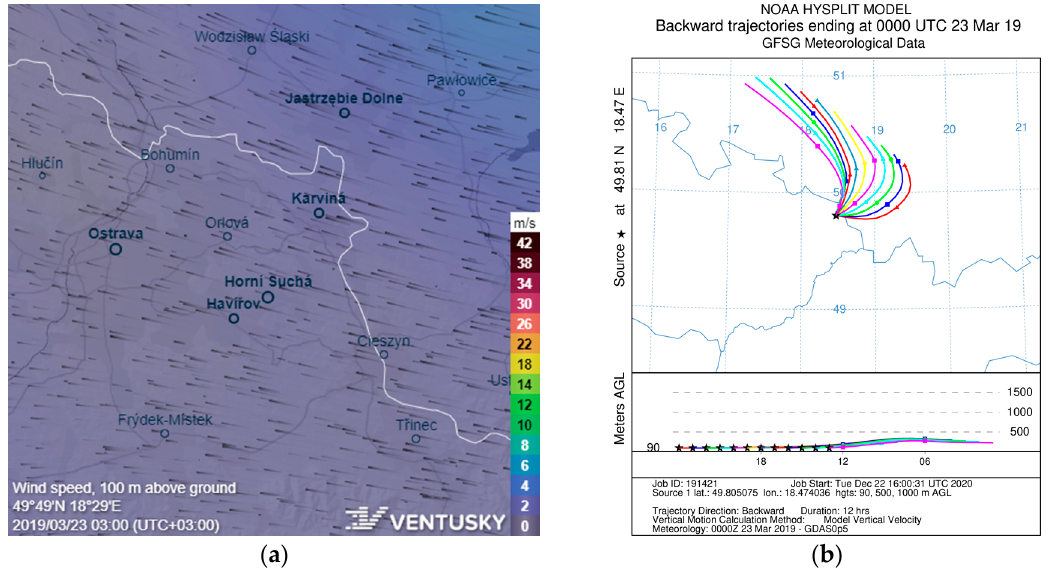
Figure 10. The modelled wind fields ( a ) and backward trajectories ( b ) for the smog situations in March 2019 [48,50,51].